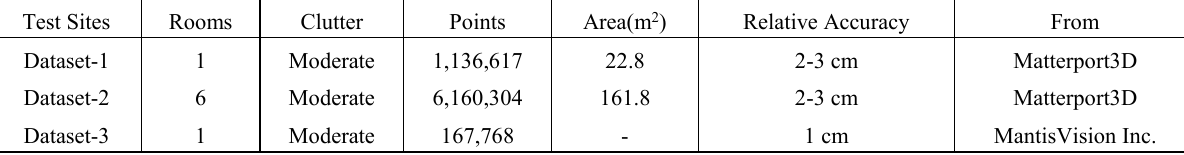
Table 3. Description of the